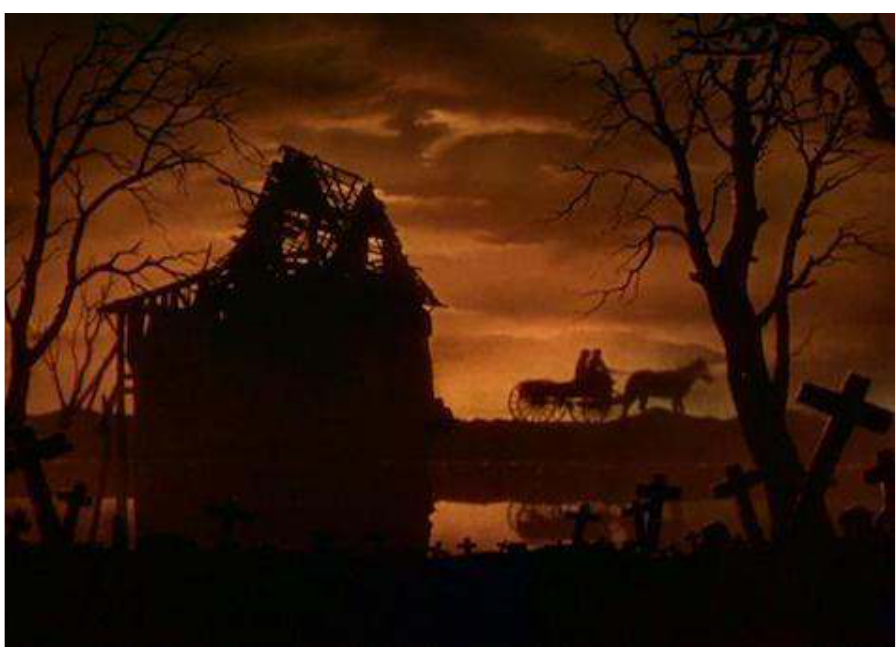
Figure 4: Derelict houses in Gone with the Wind